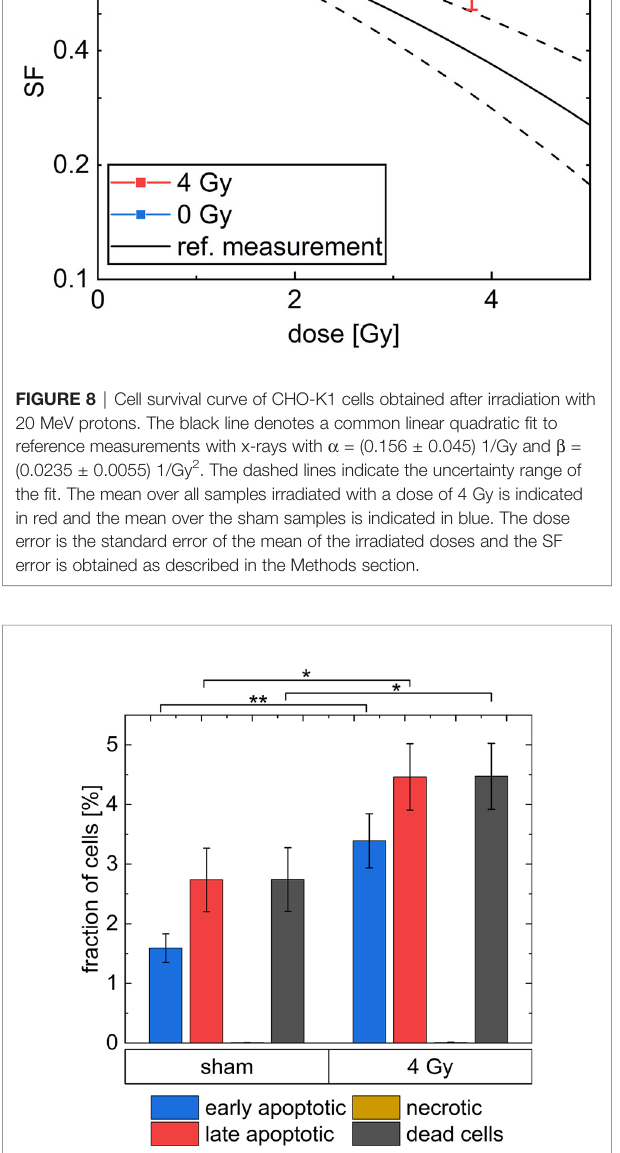
normalized cells n ( t ) = N ( t )